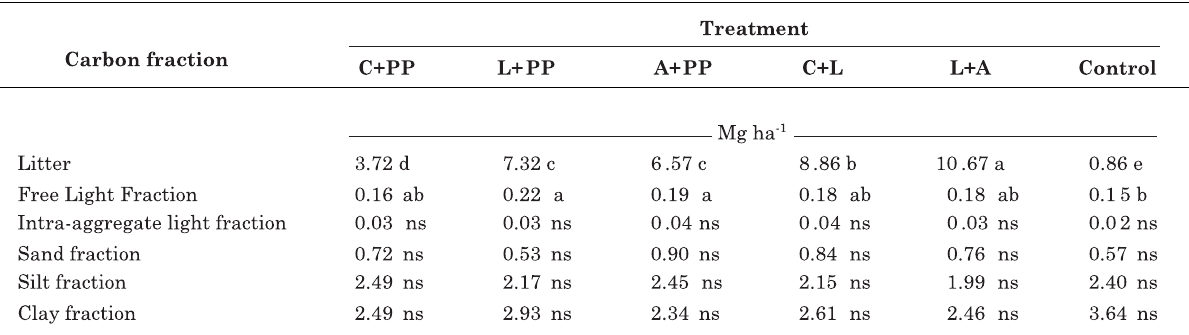
Table 2. Carbon stocks in the litter layer and different fractions of soil organic matter separated by physical fractionation at 0–10 cm depth